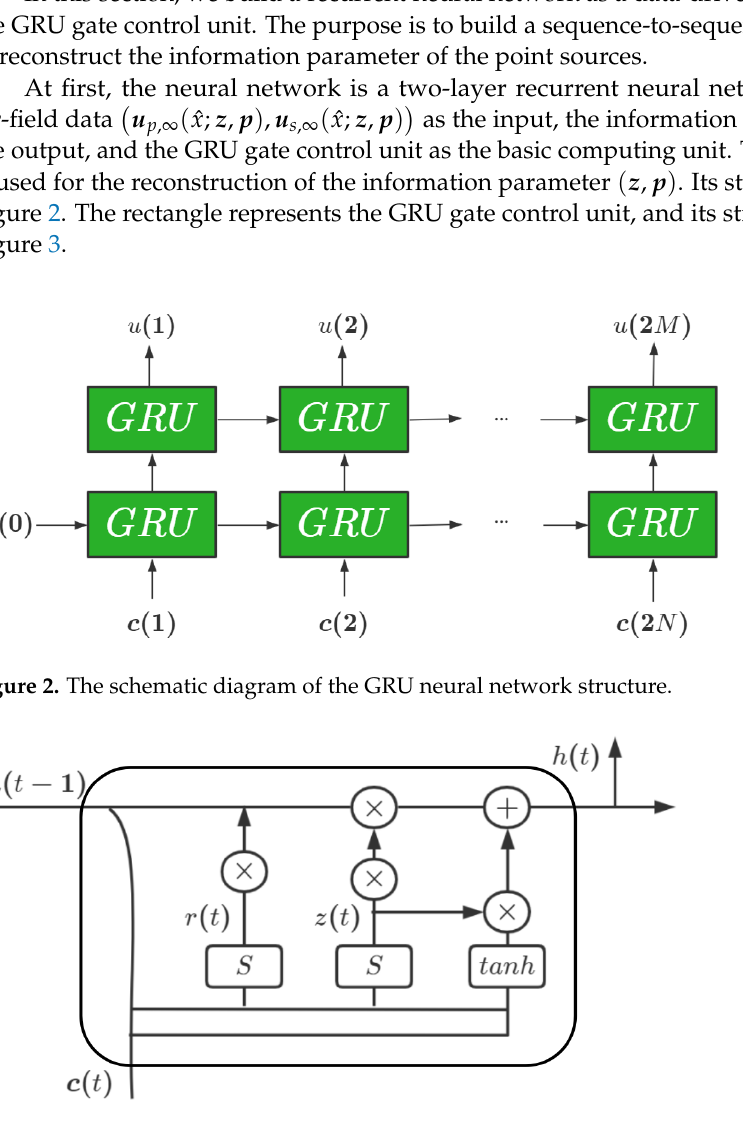
Figure 3. The schematic diagram of the GRU gate control unit